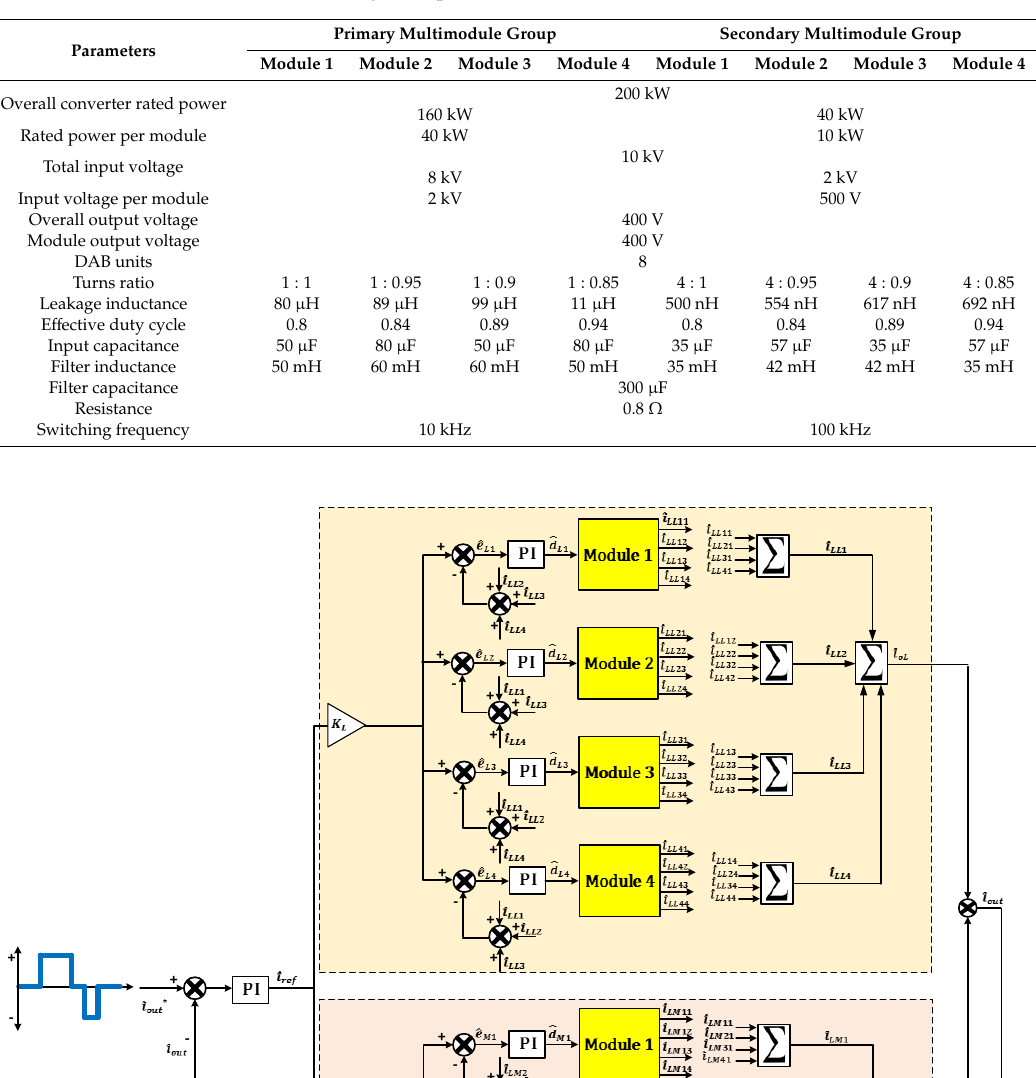
Table 4. System parameters used in simulation.